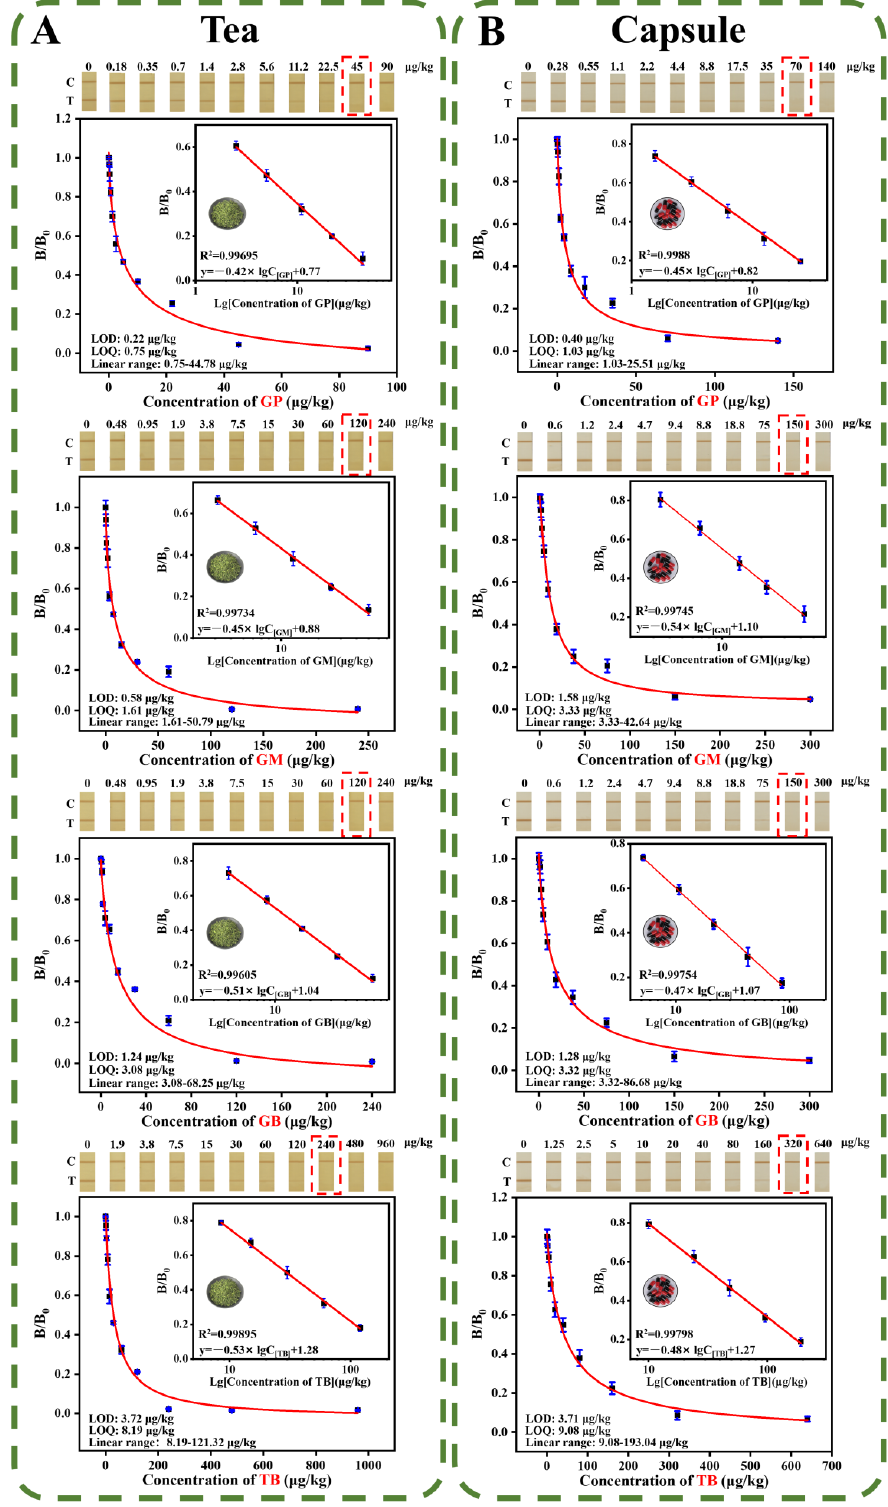
Figure 4. Performance evaluation of the PCN@PDA-LFIA. The cut-off value and calibration curves of PCN@PDA-LFIA for detecting GP/GM/GB/TB in ( A ) functional tea samples and ( B ) functional capsule samples,